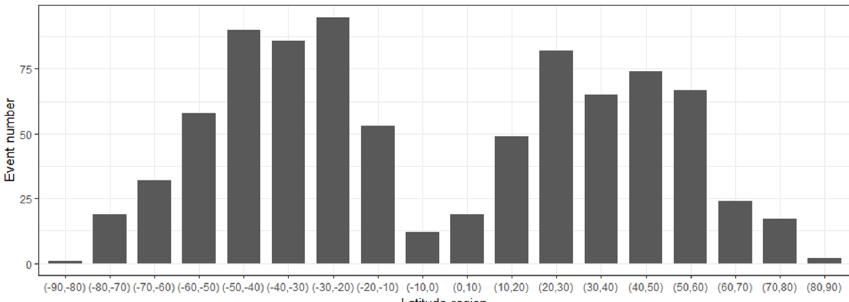
Figure 3. Number of co-located profile pairs along latitudinal